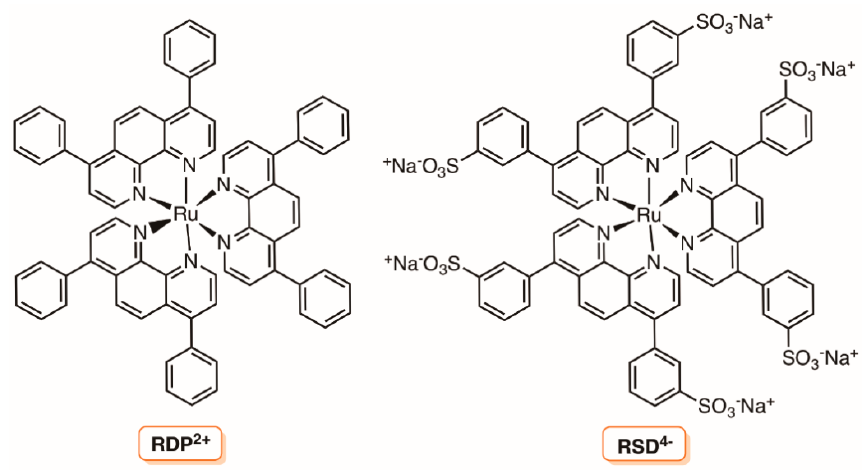
Figure 9. Structure of the ruthenium(II) complexes RDP 2+ and RSD 4 − with polyazaheterocyclic (adapted from Reference [96]).